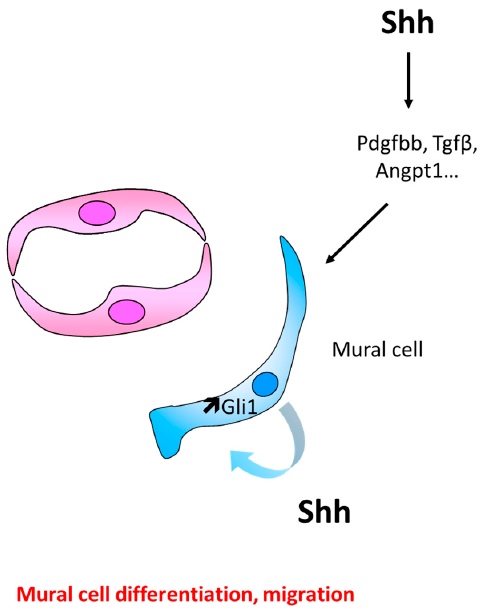
Figure 8. Schema representing the main cellular events involved in Hh-induced mural cell recruitment and differentiation. Shh may either promote mural cell differentiation and migration indirectly by upregulating Angpt1, Pdgfbb, or Tgf β in unidentified cells or by upregulating Gli1 directly in